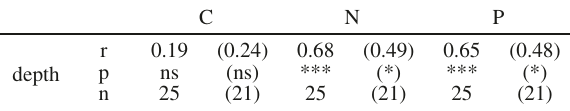
Table 9. – Correlation (r) between C, N and P content in algal tis- sues with the depth at which specimens were collected, considering all the species and (inside brackets) not including the green alga Flabellia petiolata . ns: non-significant, * p<0.05, ***